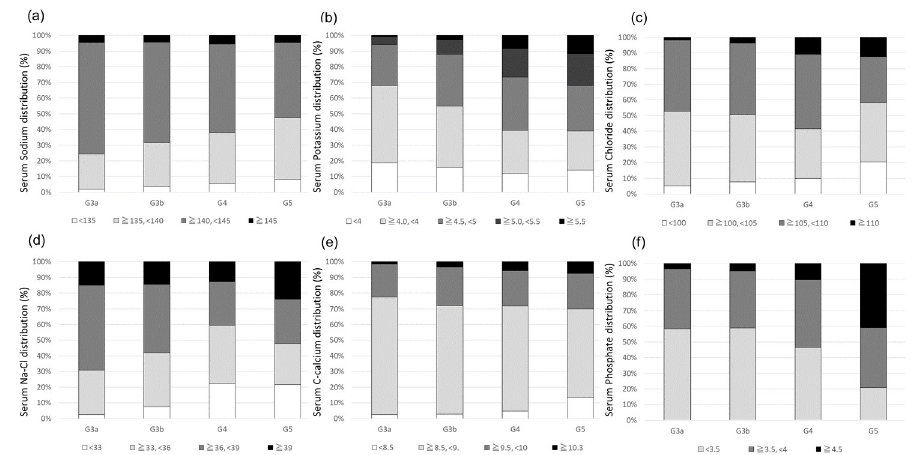
Fig 4. Serum electrolyte distribution according to G category. (a) Serum sodium distribution (%); (b) Serum potassium distribution (%); (c) Serum chloride distribution (%); (d) Serum Na–Cl distribution (%); (e) Serum corrected calcium distribution (%); and (f) Serum phosphate distribution (%). Abbreviations: Serum Na-Cl level, difference between serum sodium and chloride concentrations; C-calcium, corrected calcium.